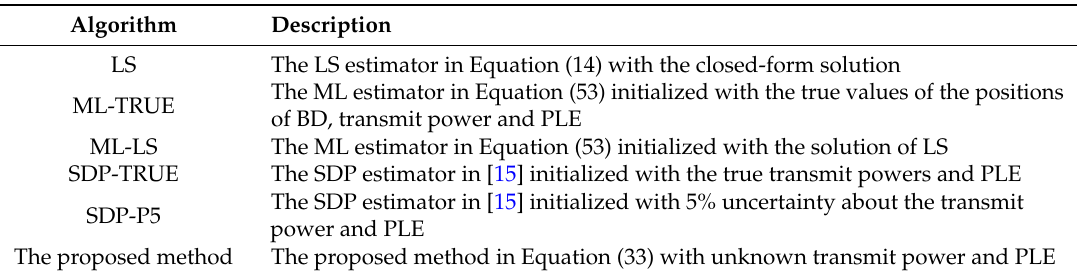
Table 1. The summary of the considered